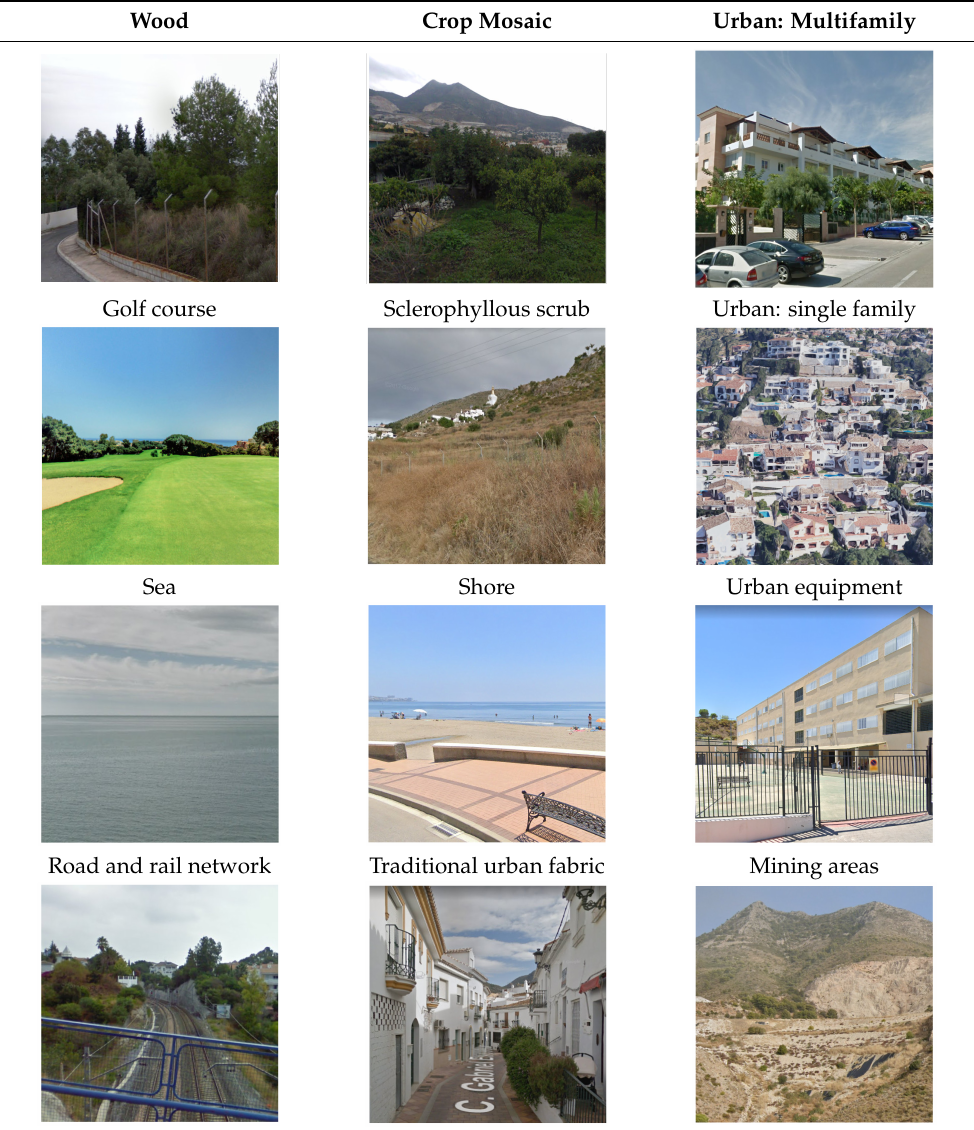
Table 1. Landscape types